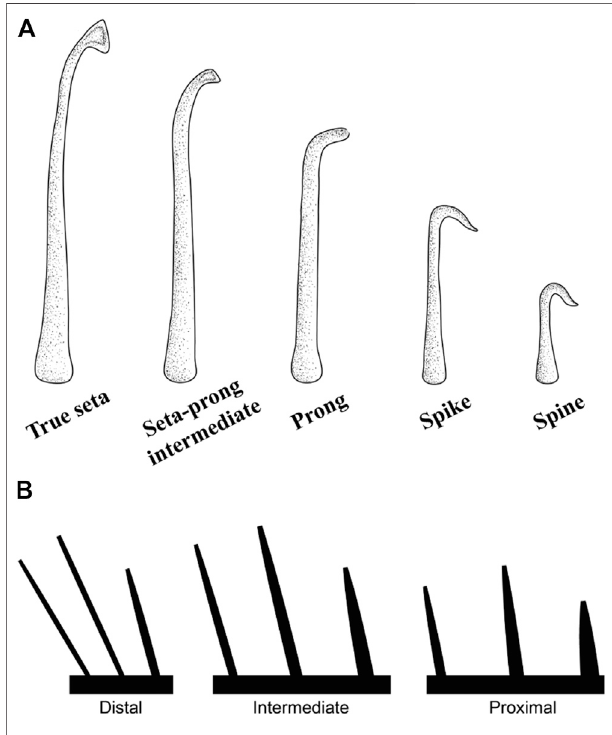
FIGURE 8 | (A) Clinal series of the epidermal outgrowths present on the subdigital pad of anoline lizards (Peterson and Williams, 1981). True setae are outgrowths between 10 – 30 μ m in length that carry a single, expanded spatulate tip. Seta-prong intermediates are outgrowths 5 – 20 μ m in lengthwith fl attened tips.Prongsterminate inablunttipwithaslight taperand are between 5 – 20 μ m in length. Spikes possess straight or recurved, pointed tips and are between 5 and 15 μ m in length. Spines are outgrowths up to 5 μ m in length with pointed recurved tips. (B) Trends of setal morphometrics along subdigital pad regions and lamellar zones of Anolis equestris (Garner et al., 2020). Setal length increases and setal base diameter decreases proximodistally along pad regions. Setal length is maximal in the intermediate zones of lamellae. Setal base diameter decreases proximodistally along lamellar zones. Lamella length decreases